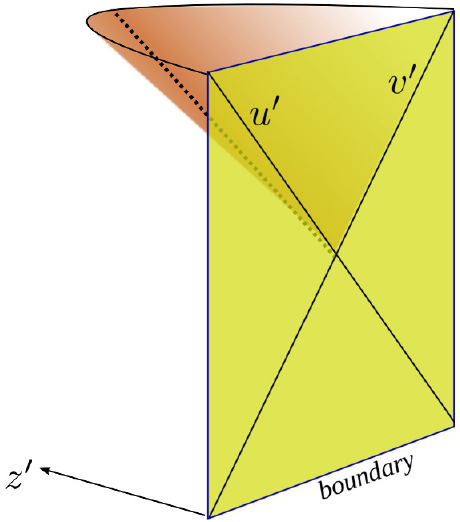
Figure 2 . Spherical shockwave (2.7) in Poincare coordinates. The source travels on a radial null geodesic that hits the boundary at the origin, u 0 = v 0 = 0. The resulting shockwave is a null